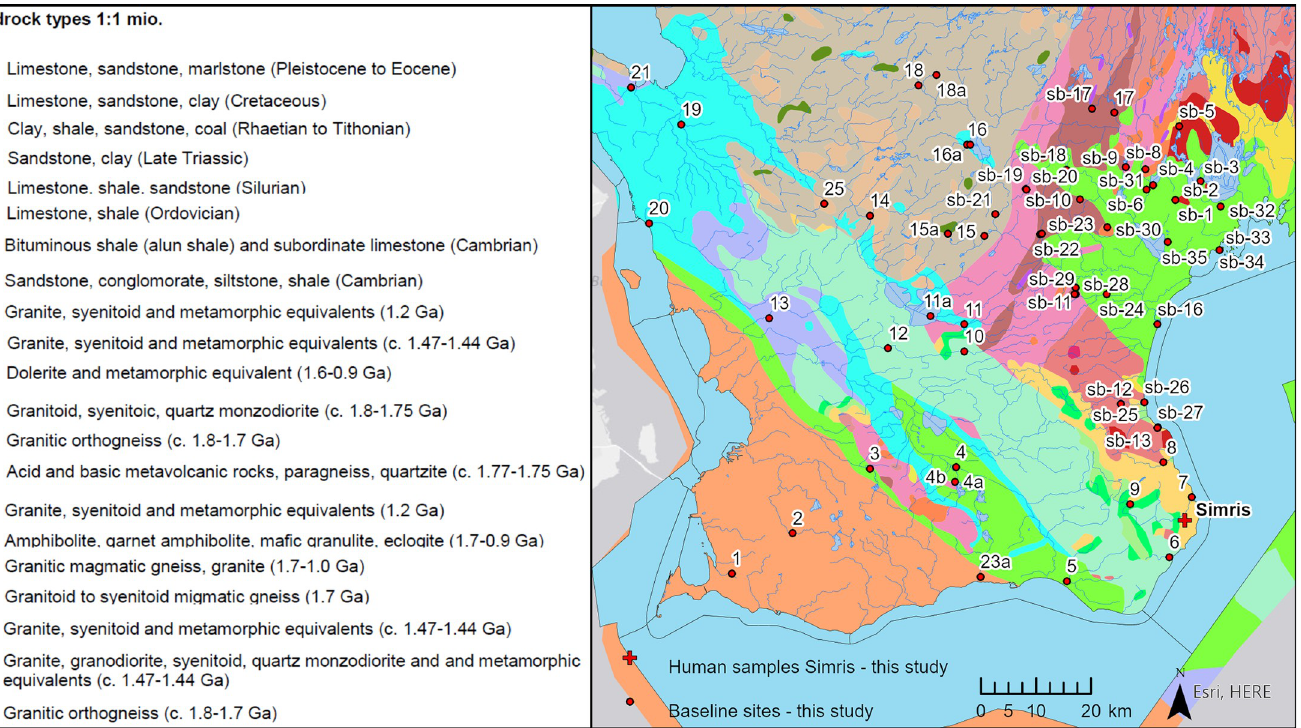
Fig 3. Baseline sampling sites of the present study, and the approximate location of the Late Bronze Age cemetery Simris II. Maps showing bedrock types and river networks of Scania extracted from the thematic 1:1 mio maps publically available from the Geological Survey of Sweden (www.sgu.se), and the Swedish Meteorological and Hydrological Institute (www.smhi.se). Maps generated using ESRI ArcGIS Pro software, licensed to the National Museum of Denmark.